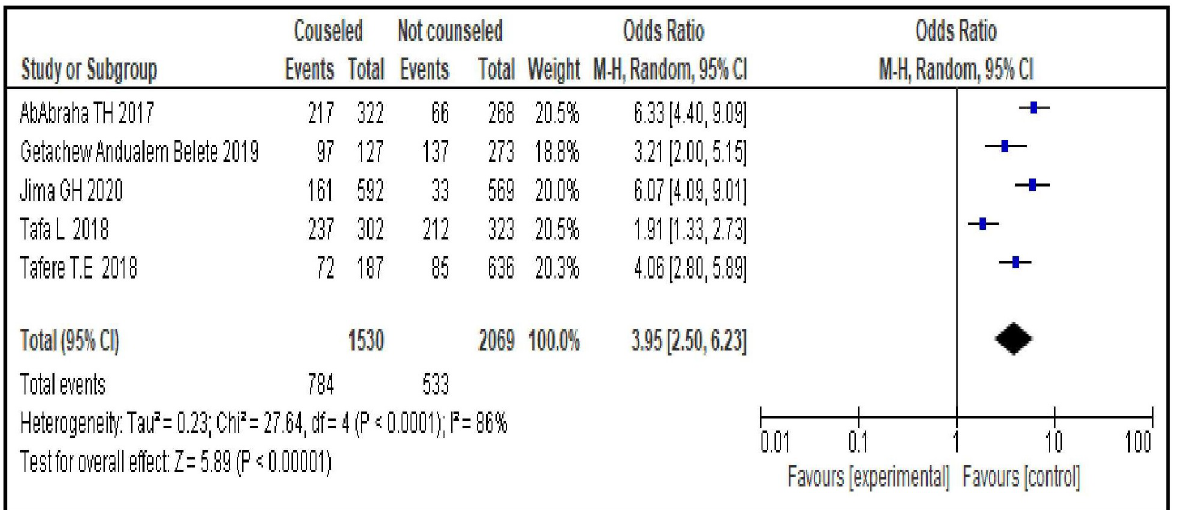
PLOS ONE | https://doi.org/10.1371/journal.pone.0270055 February 7,